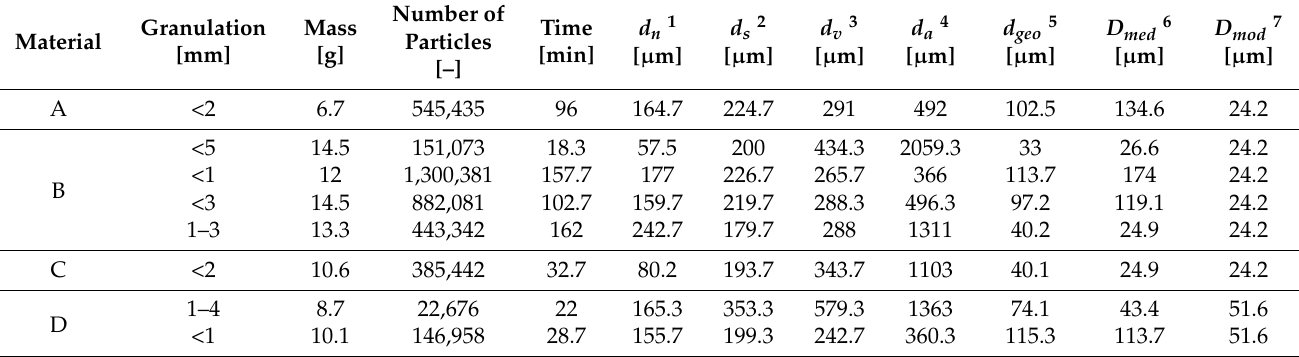
Table 3. Results of particle analysis of clay raw